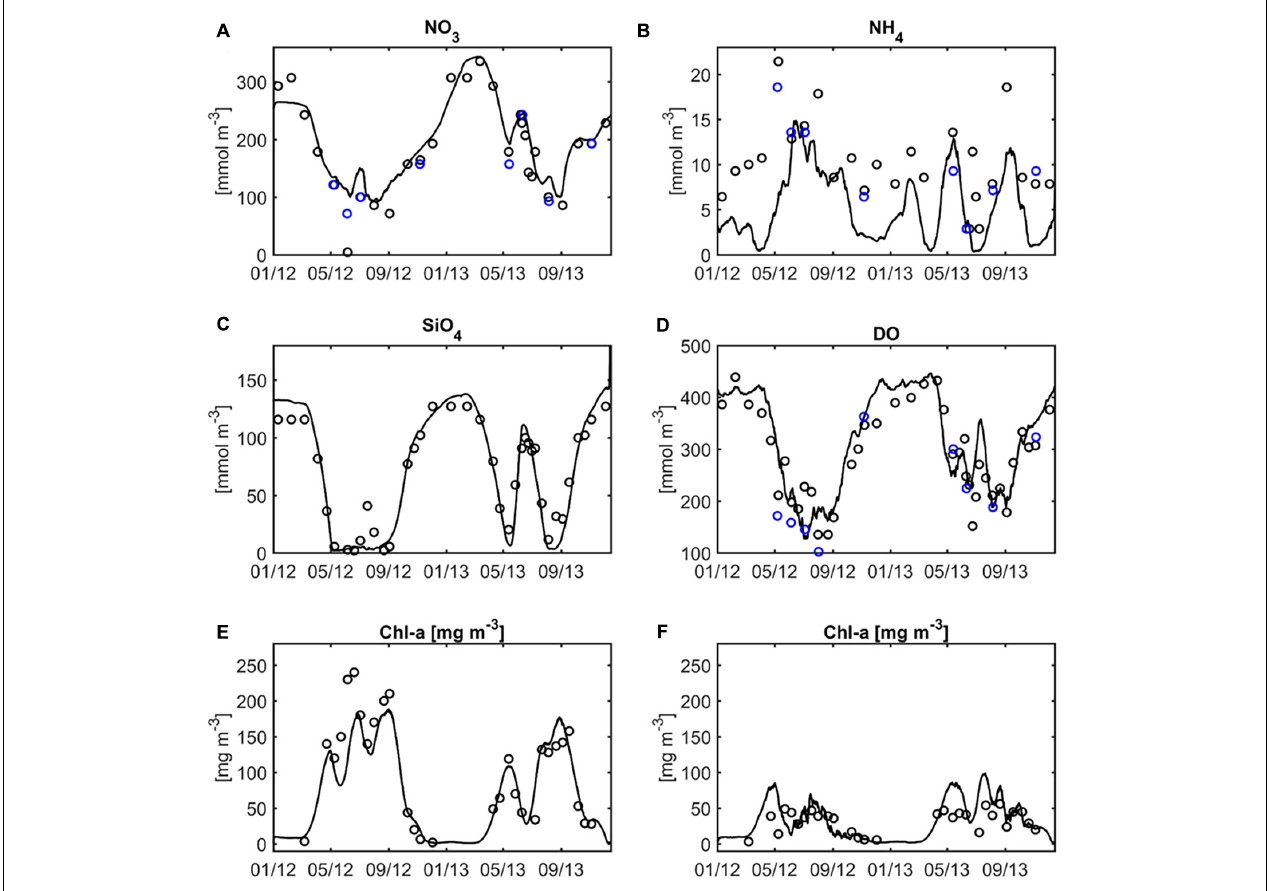
FIGURE 6 | Comparison of simulated and observed surface concentrations of (A) nitrate, (B) ammonium, (C) silicate, and (D) dissolved oxygen Seemannshöft station (see label “HH” in Figure 1 ). The bottom panels show the simulated and observed surface concentrations of chlorophyll-a at (E) Zollenspieker station (see label “ZOL” in Figure 1 ) and (F) Seemannshöft station. Blue circles in (A,B,E) represent additional observations provided by the Institute of Oceanography (IFM), University of